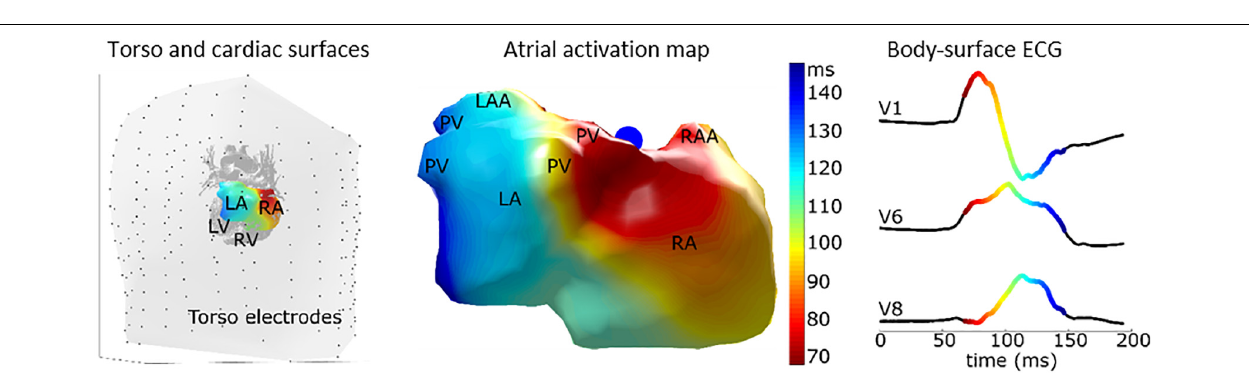
FIGURE 7 | ECGI-based (A,B) and intracardiac-based (C,D) dominant frequency maps of patients with a left-to-right dominant frequency gradient (A,C) or a right-to-left dominant frequency gradient (B,D) . Modified from Pedrón-Torrecilla et al. (2016).